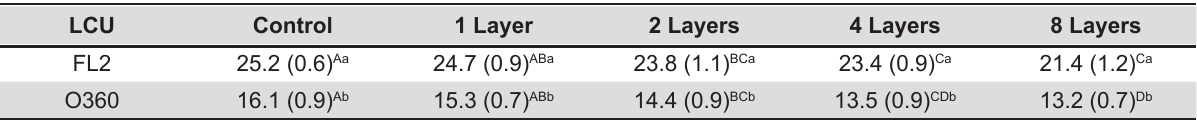
Values having the same capital letters in the rows and the same small letters in the columns are not statistically significant (p>0.05). LCU= light curing unit; FL2= Elipar FreeLight 2; O360= Optilux 360 Table 2- Means (standard deviations) of Vickers hardness number (VHN) of the lower surface of composite resin specimens light cured with light curing units covered with layers of an infection control barrier